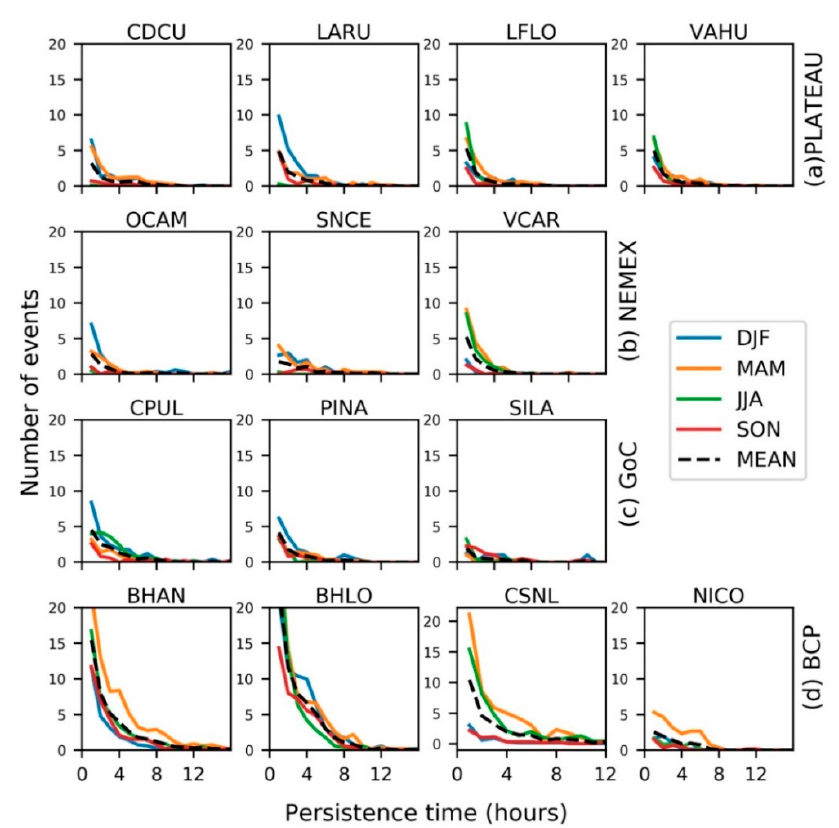
Figure 6. Seasonal mean number of extreme persistent high generation events (99 percentile of Capacity Factor) for ( a ) Plateau, ( b ) NEMEX, ( c ) GoC, ( d ) BCP regions. March–April–May (MAM),